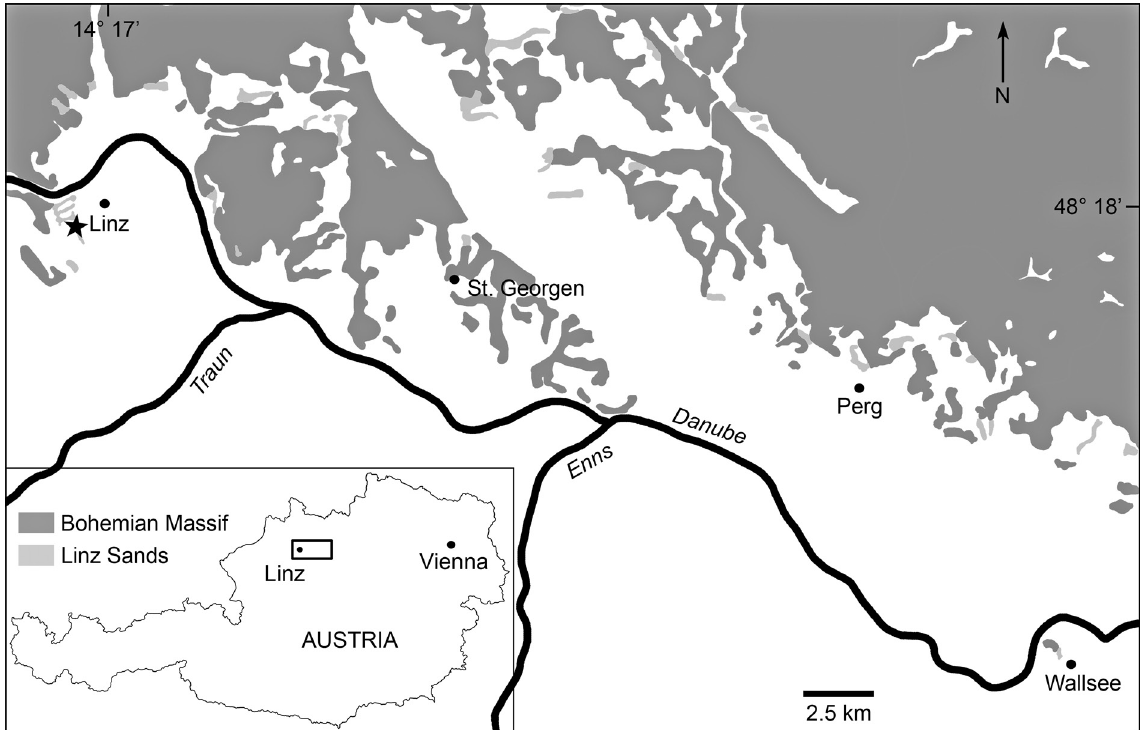
Fig. 1. Geographic and geologic overview of the Linz region, including the localities of St. Georgen/ Gusen, Perg and Wallsee. Asterisk indicates approximate type locality of Lentiarenium cristolii ( Fitzinger,